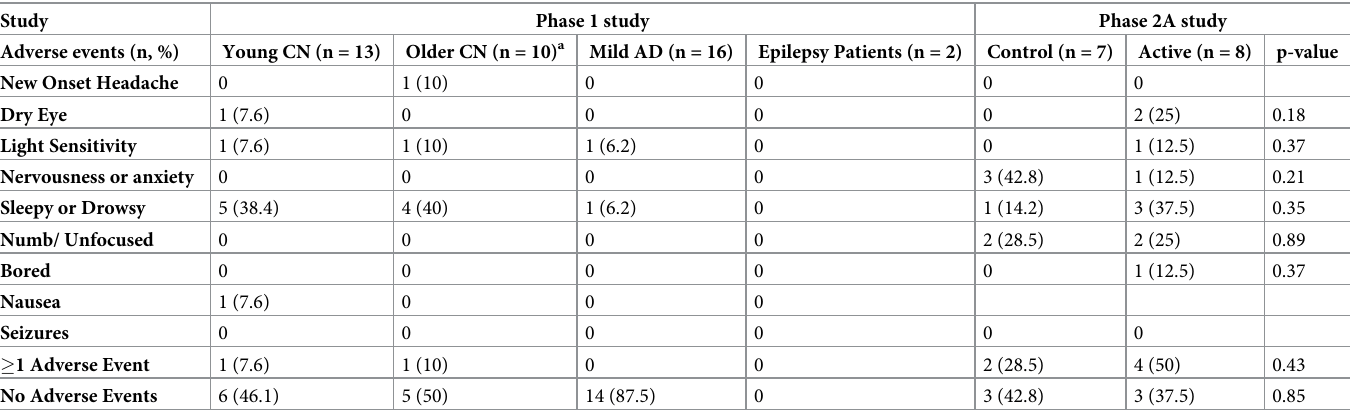
Table 3. Adverse events of acute and chronic GENUS stimulation.